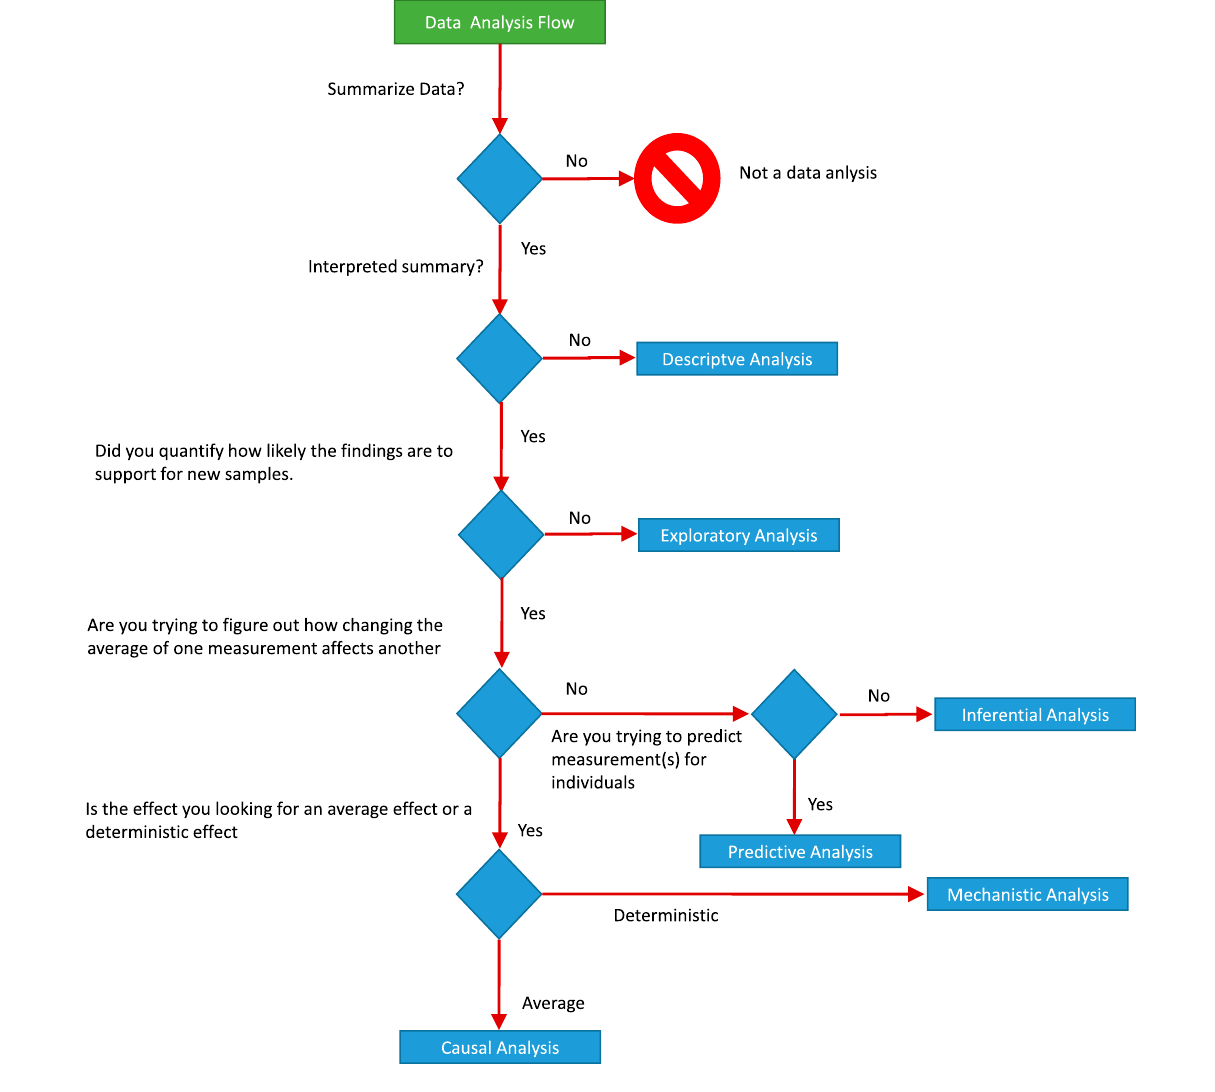
Frontiers in Arti fi cial Intelligence |